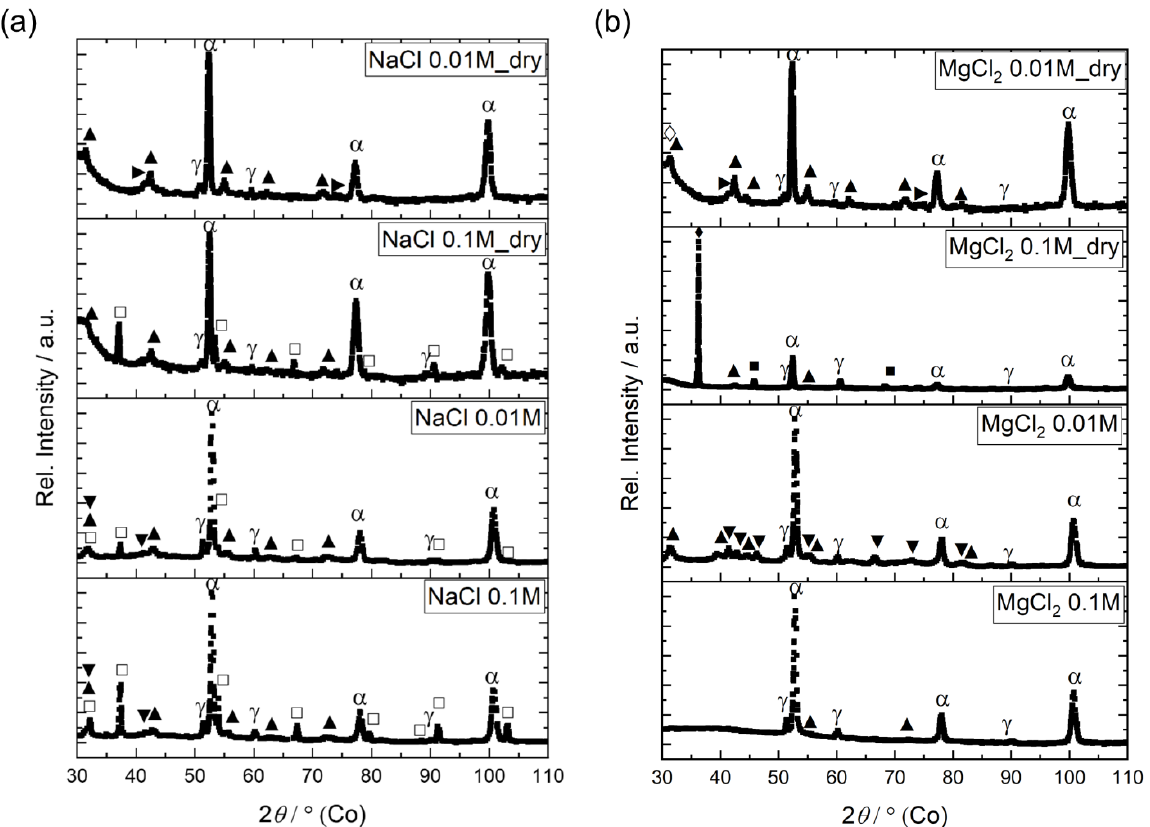
Figure 7. XRD results of corroded sample areas after application of ( a ) NaCl and ( b ) MgCl 2 solution